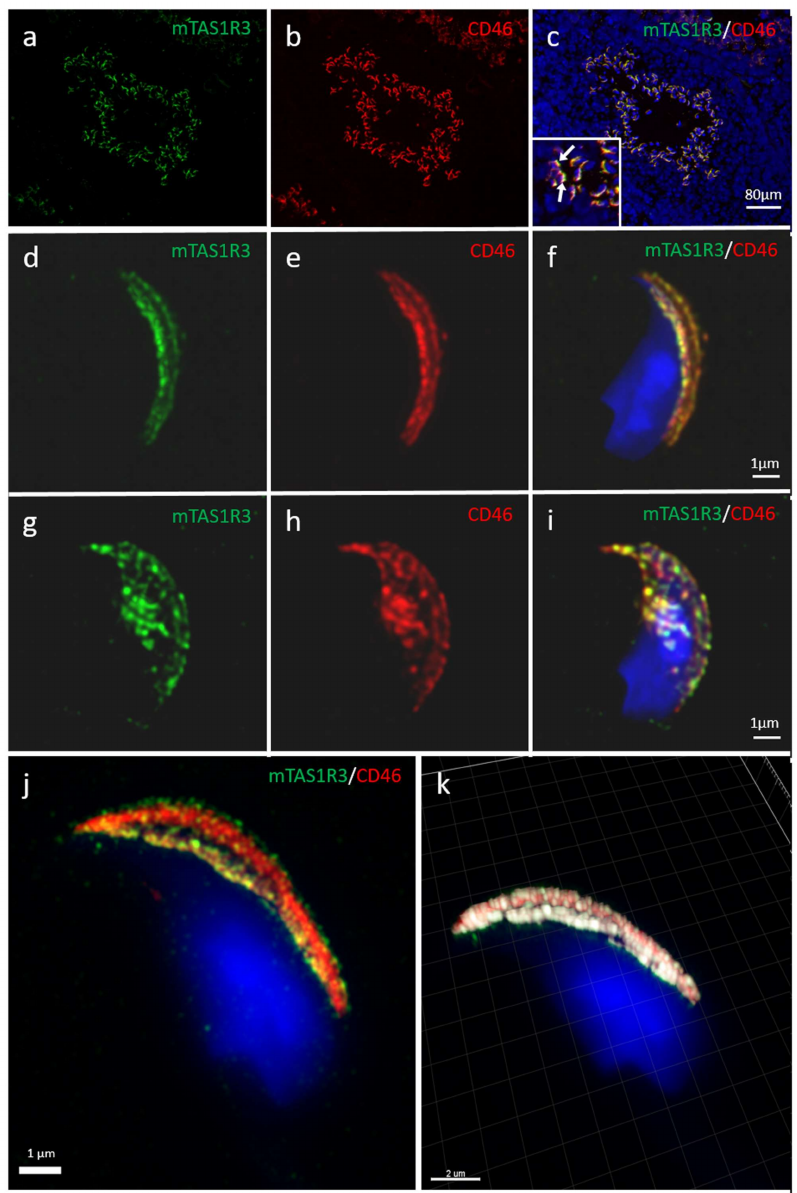
Figure 2. Localization of mTAS1R3 (green) and CD46 (red) in mouse sperm revealed by Confocal Microscopy and Structure Illumination Microscopy (SIM). During spermiogenesis ( a ) mTAS1R3